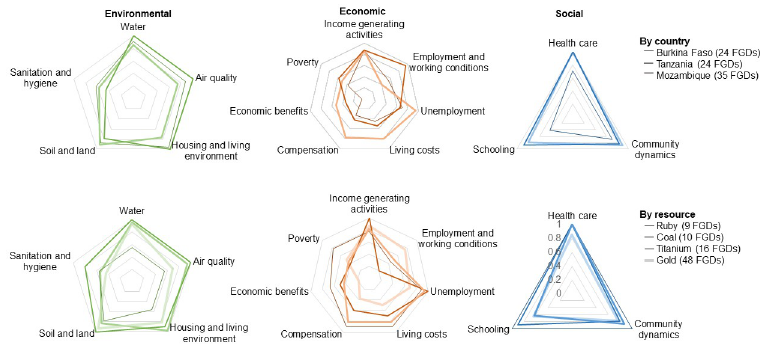
Fig 3. Consistency of findings across countries and settings. Radar graphs indicating proportion of focus group discussions (FGDs) where the different topics of environmental, economic and social aspects were discussed (0 not mentioned in any FGD, 1 mentioned in all